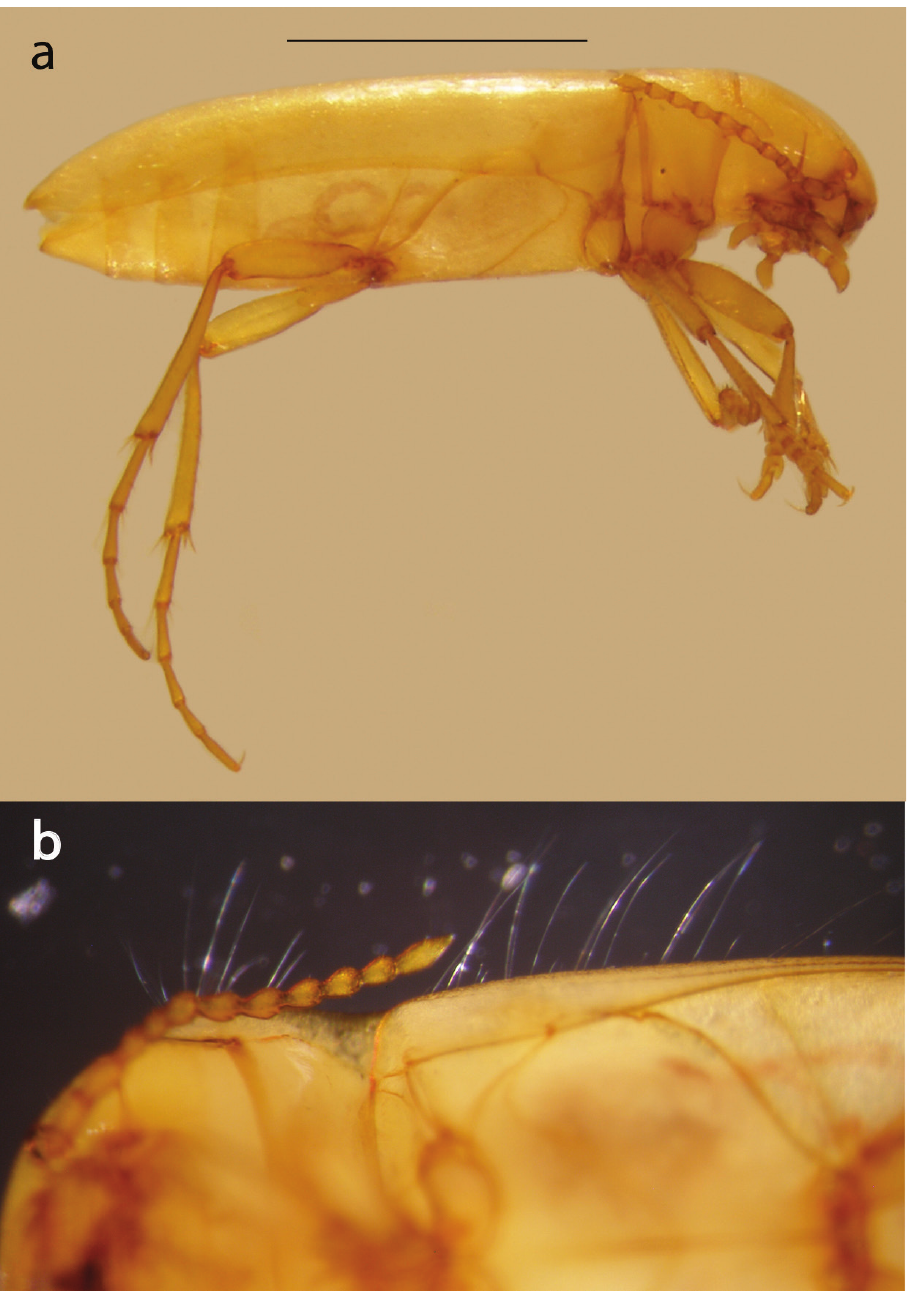
Figure 3. Iberoporus pluto sp. n., holotype. a Lateral view (scale bar, 1 mm) b Detail of the sensory setae of pronotum and elytra (both previous to DNA